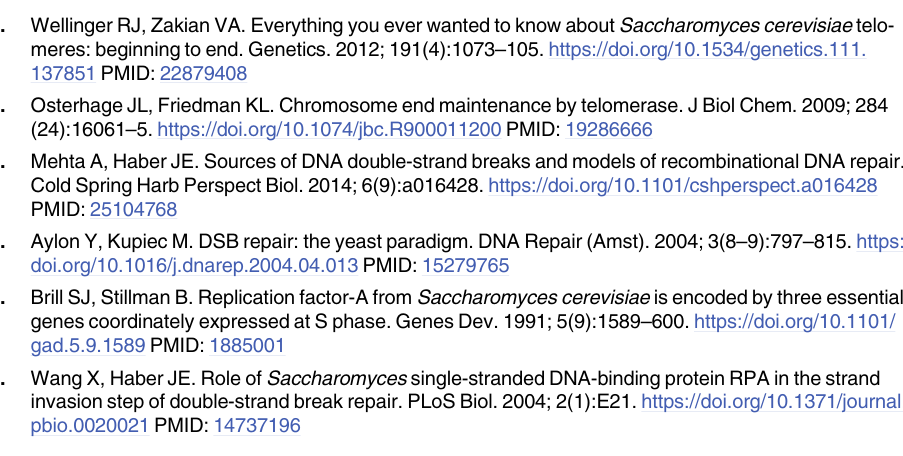
S1 Table. Frequency of telomere addition for GCR events occurring at SiRTAs. (PDF) S2 Table. List of strains. S3 Table. List of primers for chromatin